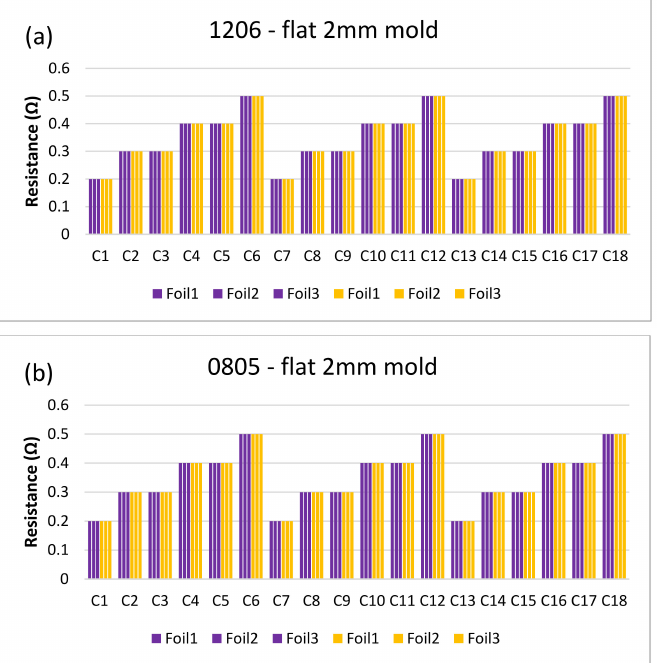
Figure 18. Resistance measurements for 1206 resistors ( a ) and 0805 resistors ( b ) molded in the 2 mm flat mold. Purple bars (before over-molding) and yellow bars (after over-molding).